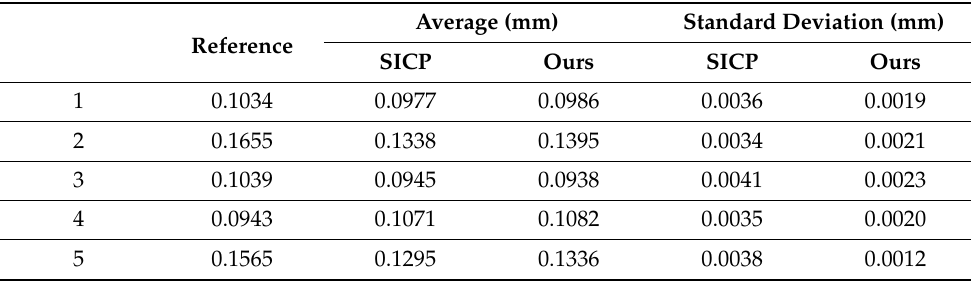
Table 4. Average, standard deviation, and the reference value of flatness measurement by the two